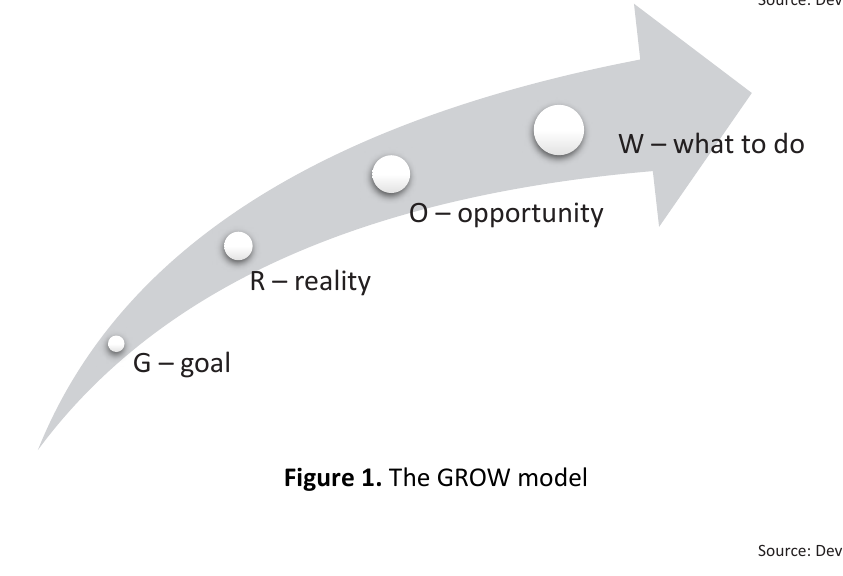
Source: Developed by the